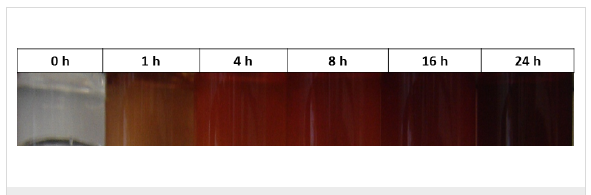
Figure 1: Photographs of silver nanoparticles 2 after different stirring